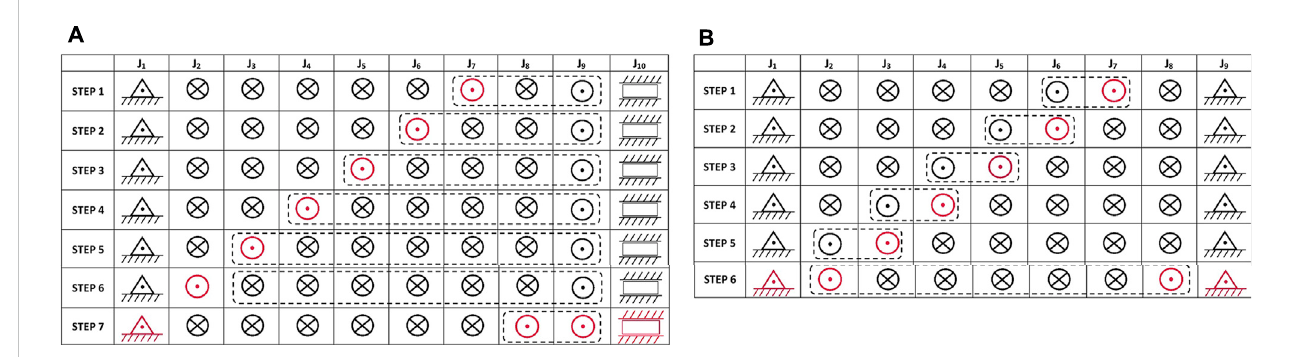
FIGURE 3 Scheduling tablesfor theECS and E4B control sequences realizing therequired shape adjustment on the linkage with eight seriallyconnected members ( ⊗ : locked joint, ⊙ : unlocked joint, △ : pivoted – to – the-ground joint, : slider joint). Dashed-line encirclements denote the effective coupler links. The red colored symbols represent the currently adjusted joints: (A) Sequence based on the ECS approach; (B) Sequence based on the E4B approach.